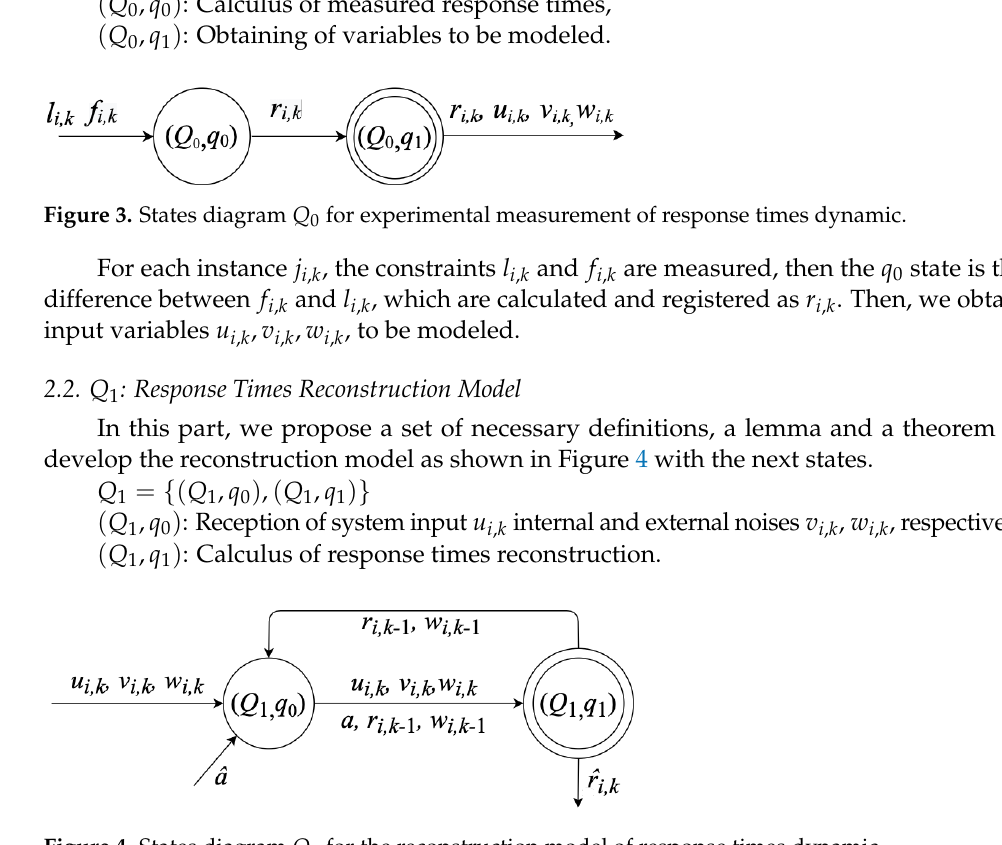
Figure 4. States diagram Q 1 for the reconstruction model of response times